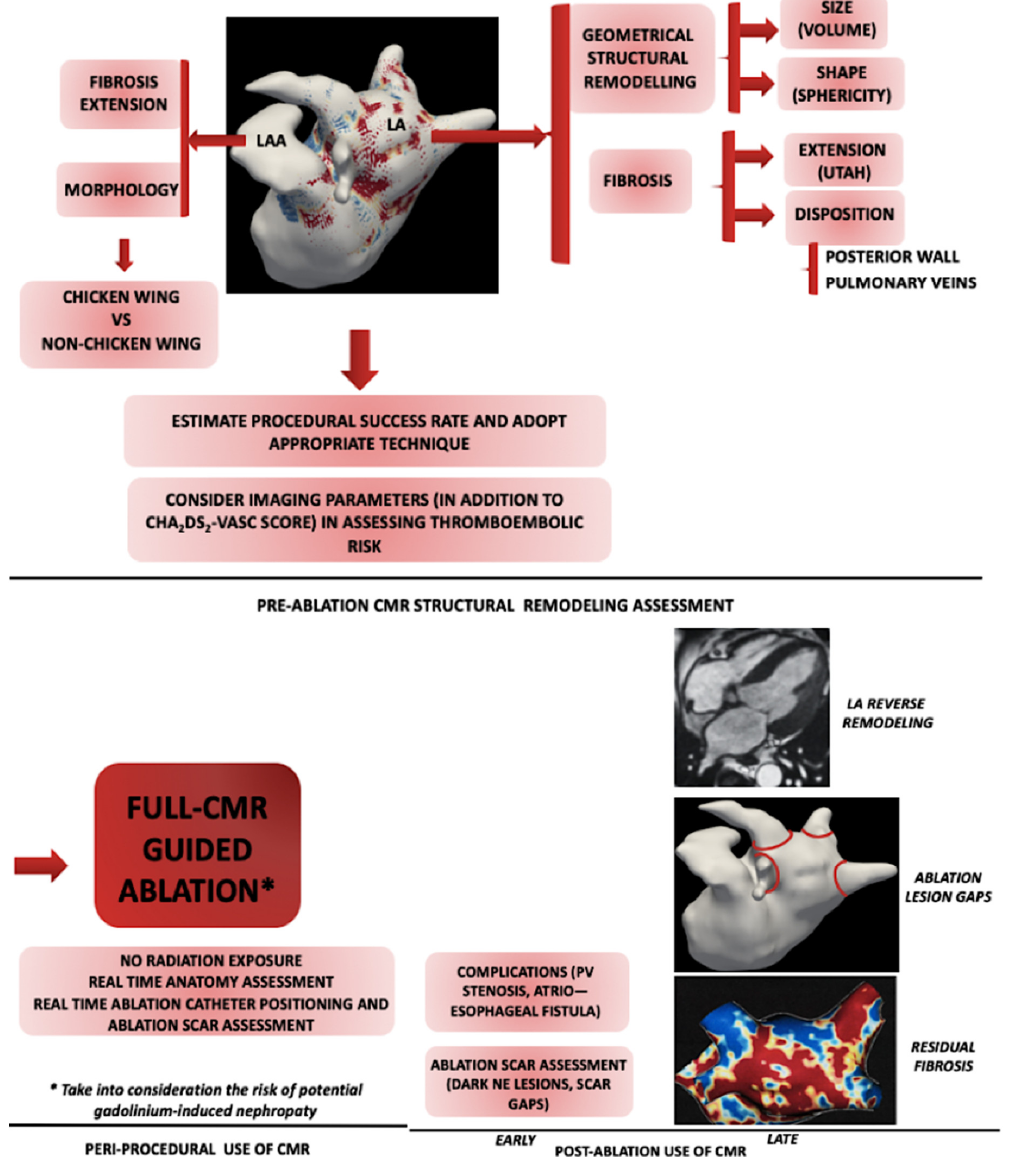
Figure 4. The use of CMR imaging in relation to the timing of the index procedure (up, center- pre-ablation, down-left- peri-procedural and down-right- post-ablation). Preablation, the degree of structural remodeling can be assessed through LA volume, sphericity and fibrosis extension and disposition. New techniques are being explored to allow performing full CMR-guided ablation. Post-ablation, CMR is used immediately after the procedure to scan for possible complications